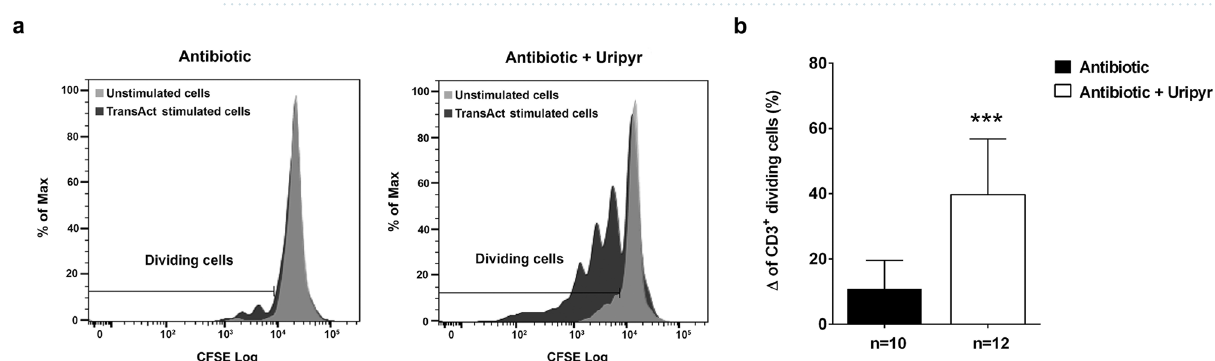
Figure 3. Effects of Uripyr oral supplementation on the ex vivo proliferation of CD3 + gated cells from PBMCs of mitotoxic antibiotic-treated patients. ( a ) Representative overlay histograms for CFSE staining of CD3 + gated cells from PBMCs of Uripyr and control group. The histograms indicate the proliferating ability of unstimulated (grey histograms) and TransAct stimulated (black histograms) cells. ( b ) The mean percentage of dividing CD3 + gated cells from PBMCs was calculated as delta value of TransAct stimulated vs. unstimulated cells after antibiotic treatment—with and without Uripyr supplement (white and black bars, respectively). Data are expressed as mean ± SEM. ***p ≤